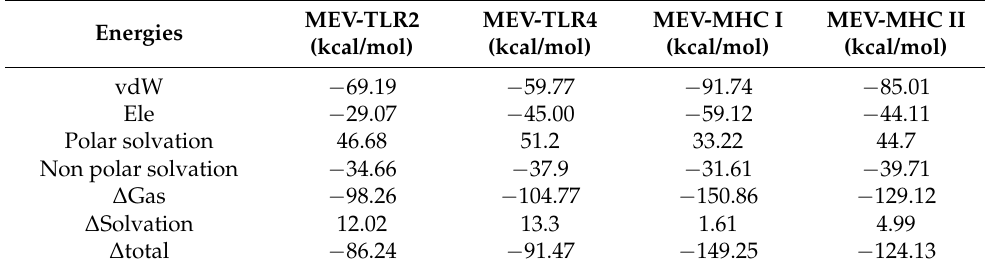
Table 6. Binding energies of the MEV to the human receptors and MHC molecules. Energies